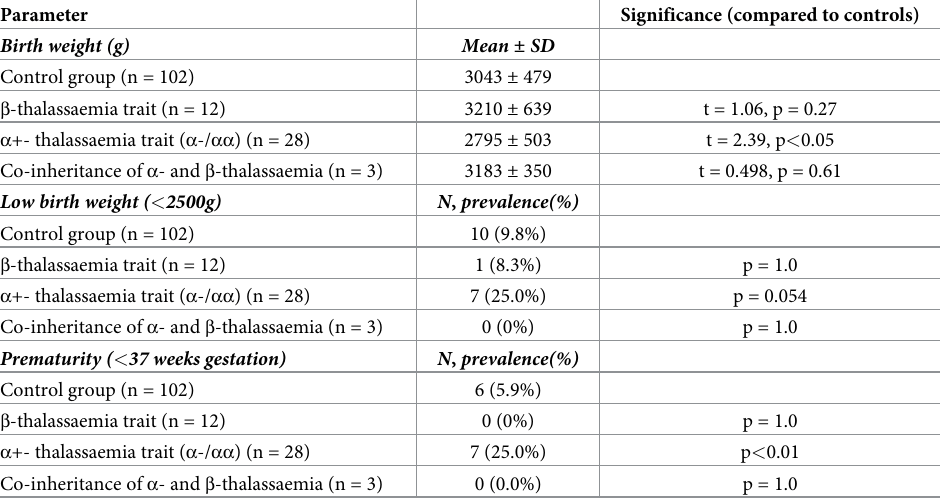
Table 4. Birth outcome of off springs of different heterozygous thalassaemia conditions. Parameter Significance (compared to controls) Birth weight (g) Mean ± SD Control group (n = 102) 3043 ± 479 β -thalassaemia trait (n = 12) 3210 ± 639 t = 1.06, p = 0.27 α +- thalassaemia trait ( α -/ αα ) (n = 28) 2795 ± 503 t = 2.39, p < 0.05 Co-inheritance of α - and β -thalassaemia (n = 3) 3183 ± 350 t = 0.498, p = 0.61 Low birth weight ( < 2500g) N , prevalence(%) Control group (n = 102) 10 (9.8%) β -thalassaemia trait (n = 12) 1 (8.3%) p = 1.0 α +- thalassaemia trait ( α -/ αα ) (n = 28) 7 (25.0%) p = 0.054 Co-inheritance of α - and β -thalassaemia (n = 3) 0 (0%) p = 1.0 Prematurity ( < 37 weeks gestation) N , prevalence(%) Control group (n = 102) 6 (5.9%) β -thalassaemia trait (n = 12) 0 (0%) p = 1.0 α +- thalassaemia trait ( α -/ αα ) (n = 28) 7 (25.0%) p < 0.01 Co-inheritance of α - and β -thalassaemia (n = 3) 0 (0.0%) p = 1.0